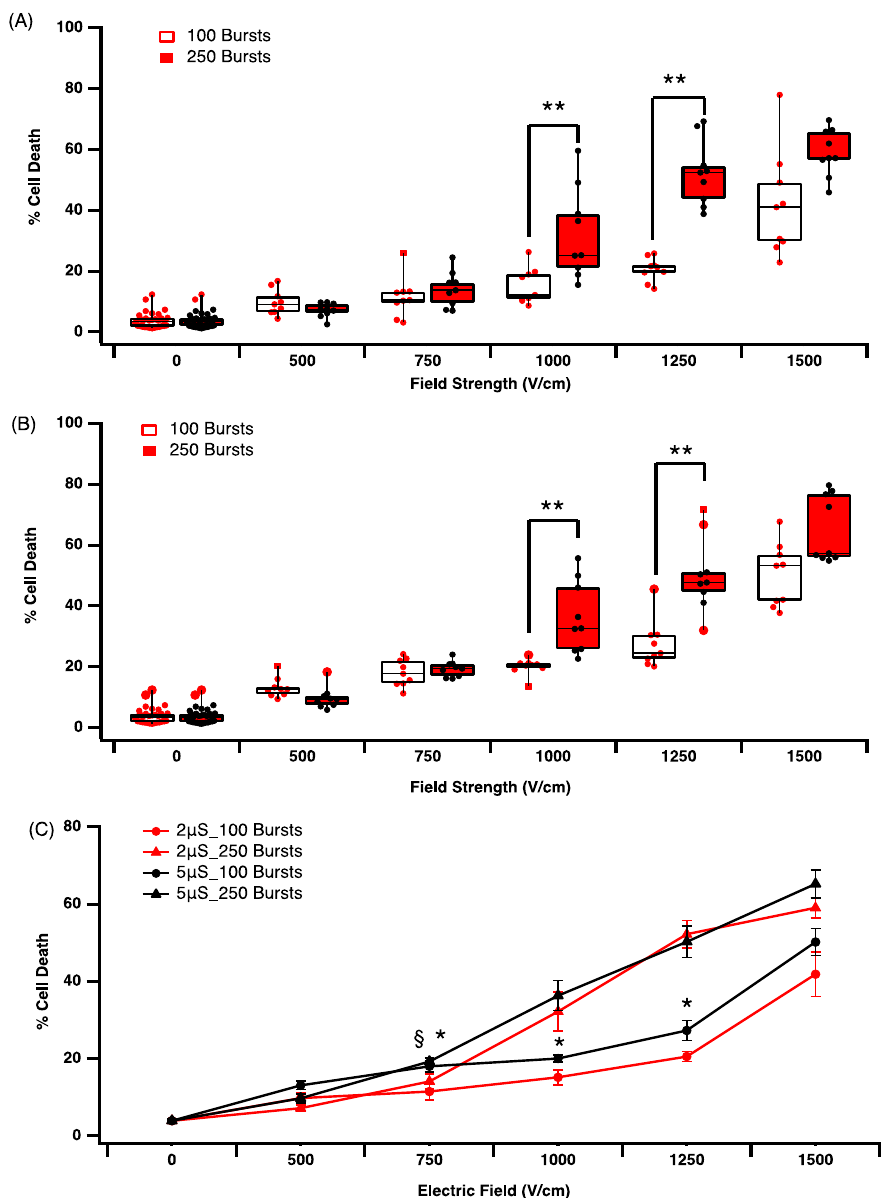
Figure 3. Increasing pulse duration, burst number and field strength reduces cardiomyocyte viability. ( A ) Effect of 2 µ s pulse duration on cell survival. ( B ) Effect of 5 µ s pulse duration on cell survival. ( C ) Comparison of 2 µ s versus 5 µ s pulse duration on human cardiomyocyte survival. Data are representative of at least 3 independent experiments and plotted as max, min and median. § p < 0.05, * p < 0.005, ** p < 0.001, one-way ANOVA, Dunnett’s post-hoc test.